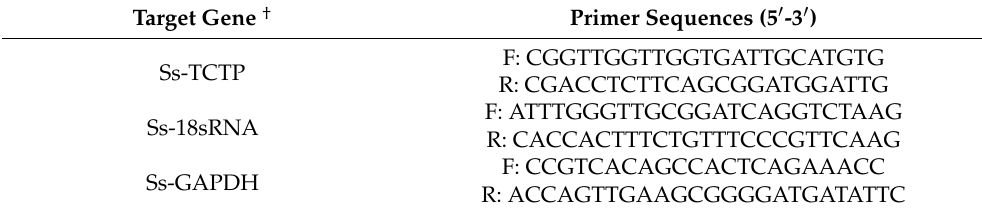
Table 1. Primers used in